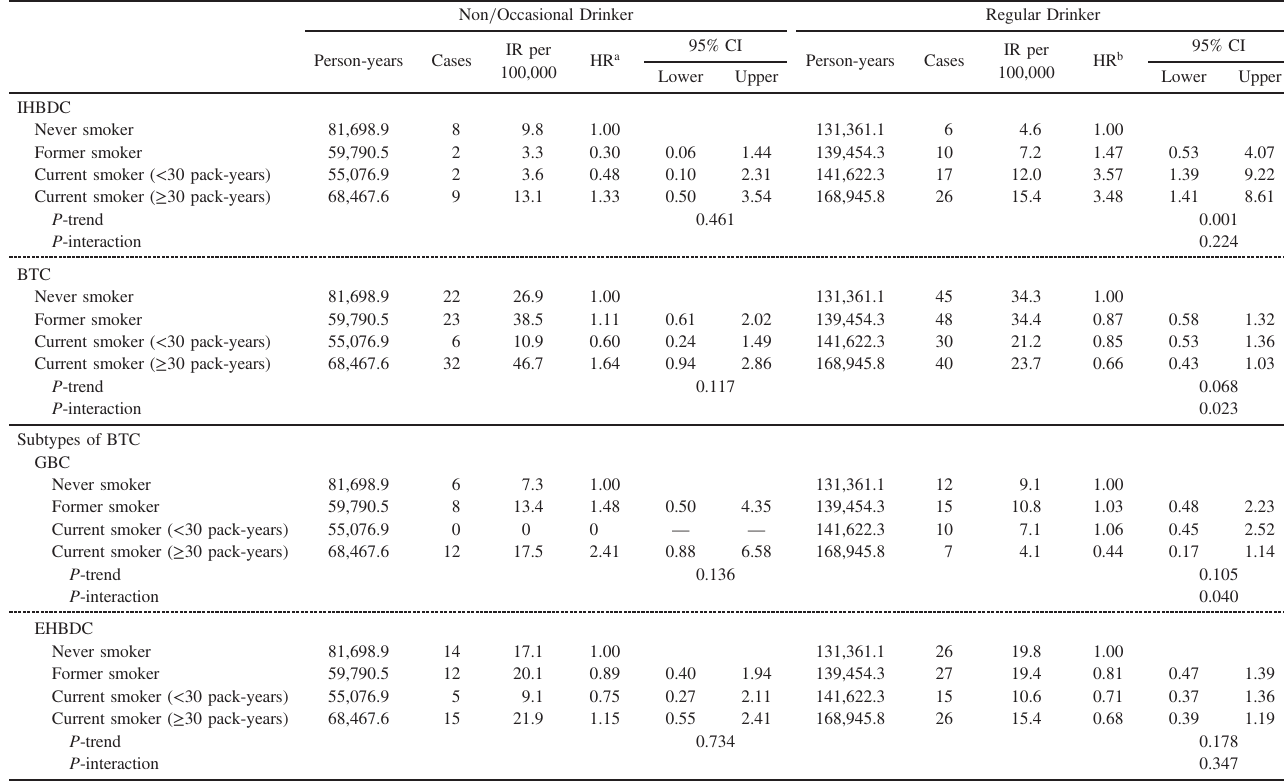
Table 4. HRs and 95% CIs of the incidence of BTC and IHBDC according to smoking strati fi ed by drinking status in men Non = Occasional Drinker Regular